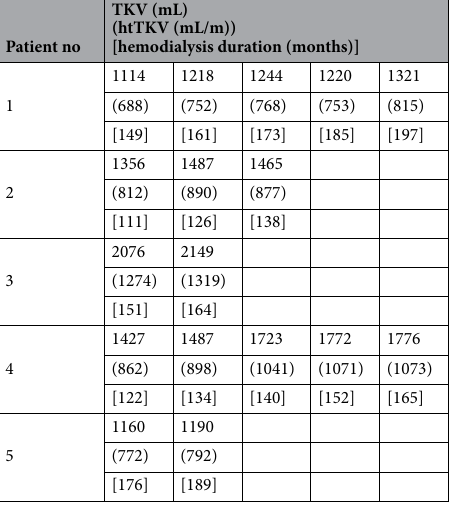
Table 3. Changes in total kidney volume (TKV) and height-adjusted total kidney volume (htTKV) in autosomal dominant polycystic kidney disease (ADPKD) patients of non-cinacalcet group (n = 5). ADPKD autosomal dominant polycystic kidney disease, TKV total kidney volume, htTKV height adjusted total kidney volume.